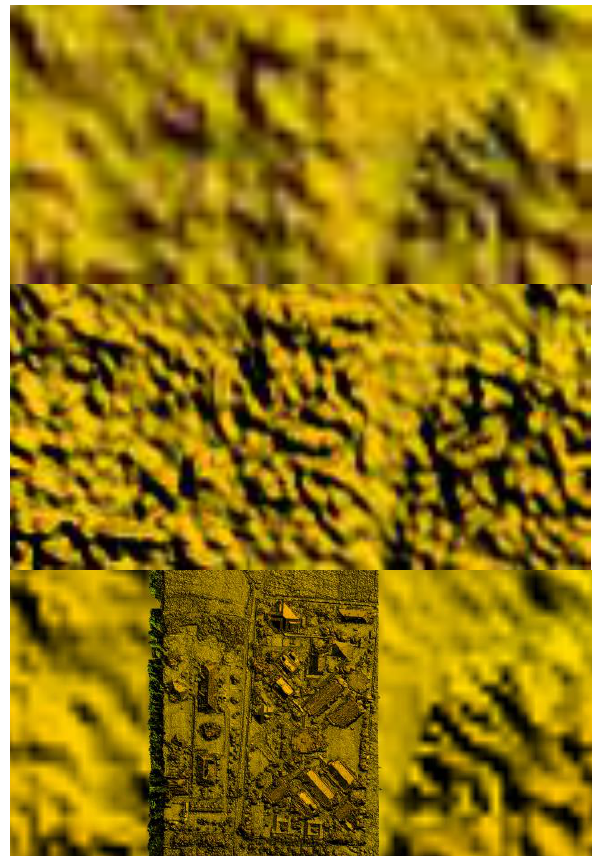
Figure 7 DSM Resolution for the test area: IDEM 12 m (upper), Generated DEM 6 m (middle) and Leica RCD-30 10 cm